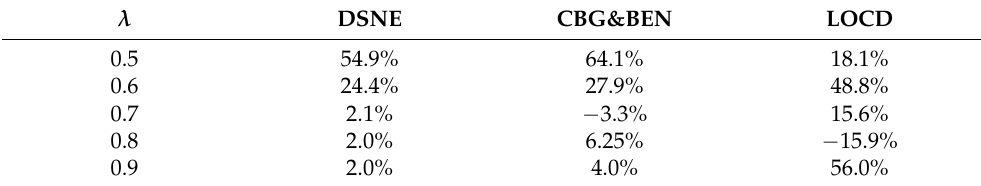
Table 2. When N = 256, NMI decreasing speed with noise increasing ( λ decreasing) under different algorithms.